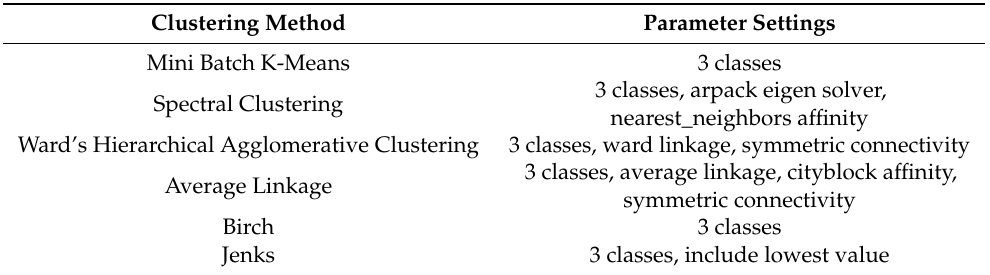
Figure 4. Evaluation process of clustering methods. Table 6. Parameter settings for clustering